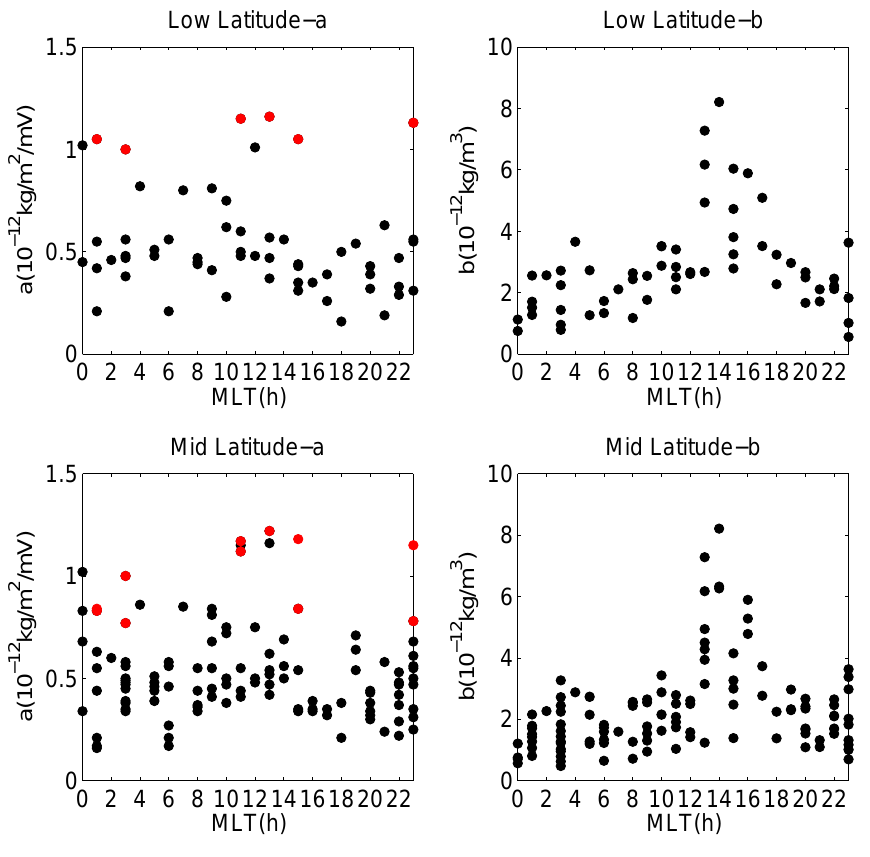
Fig. 3. Coefficients derived from the linear regression of Eq. (9) as the function of MLT. Results are derived separately for low and mid latitudes. The distribution of parameters a and b are displayed in the left and right columns, respectively. Red dots mark the a-values of 3 super